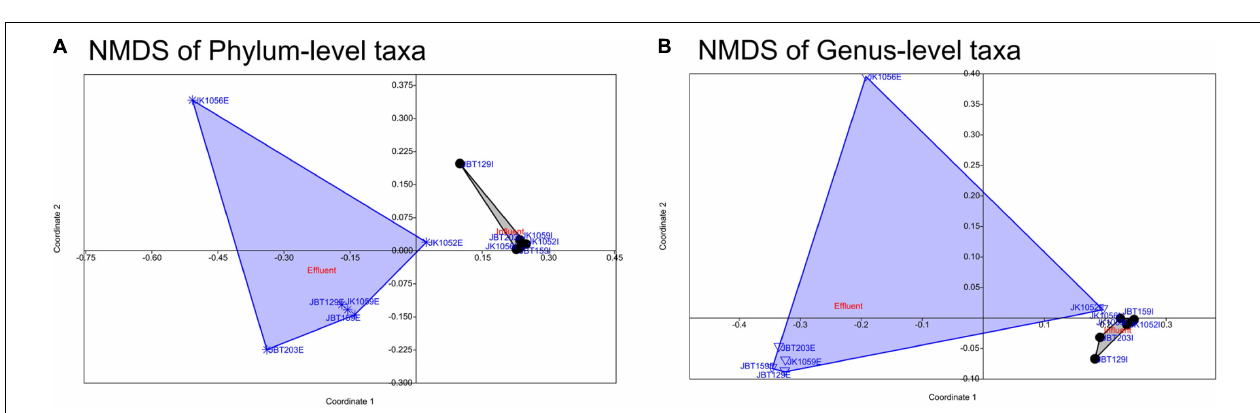
FIGURE 5 | Principal component analysis (PCA) of the (A) phylum-level and (B) genus-level microbial taxa composition.